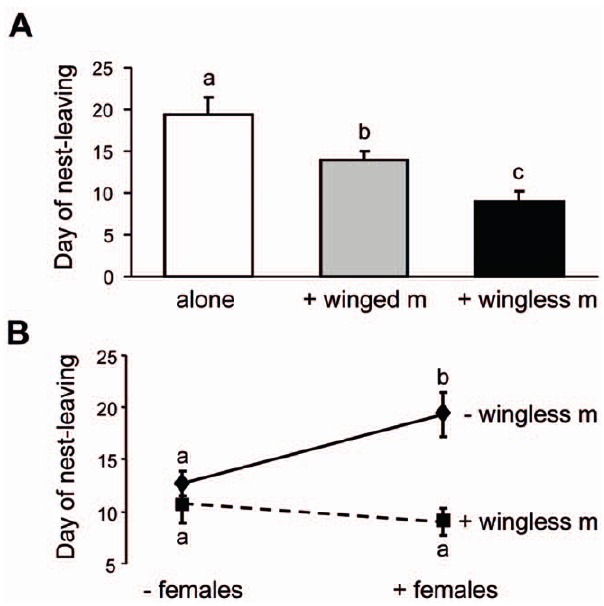
Figure 1. Dispersal time of winged Cardiocondyla males from their natal nest. A ) In the presence of virgin queens, winged males stayed longer in the colony when being the single male in the colony (white) than when another male was present. They emigrated earlier when the second male was a wingless fighter male (black) than when it was a peaceful winged male (grey; mean 6 s.d., significance